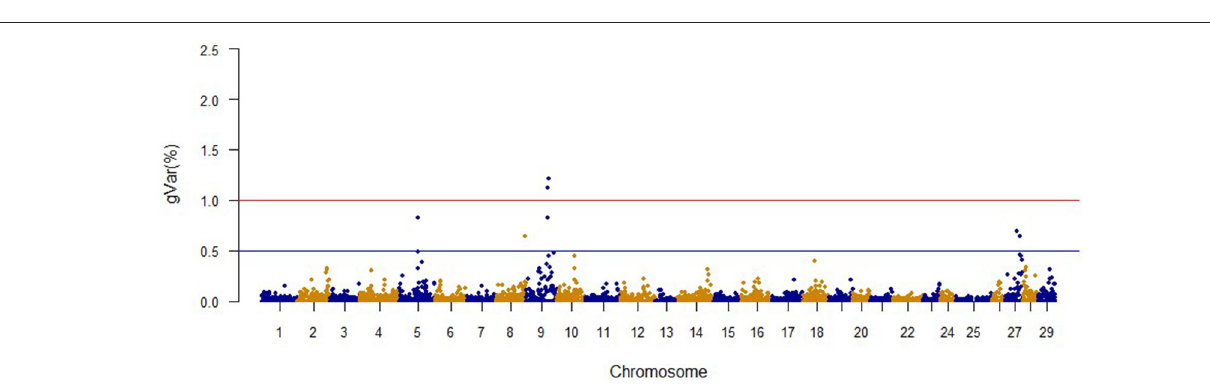
FIGURE 1 | The proportion of genetic variance explained by 20-SNP regions for fillet yield.